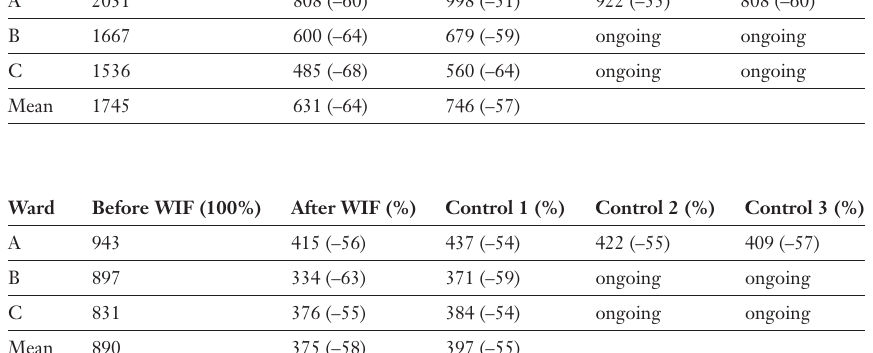
Number of different drug packages before and after introducing the ward-individu- alised formulary (WIF).